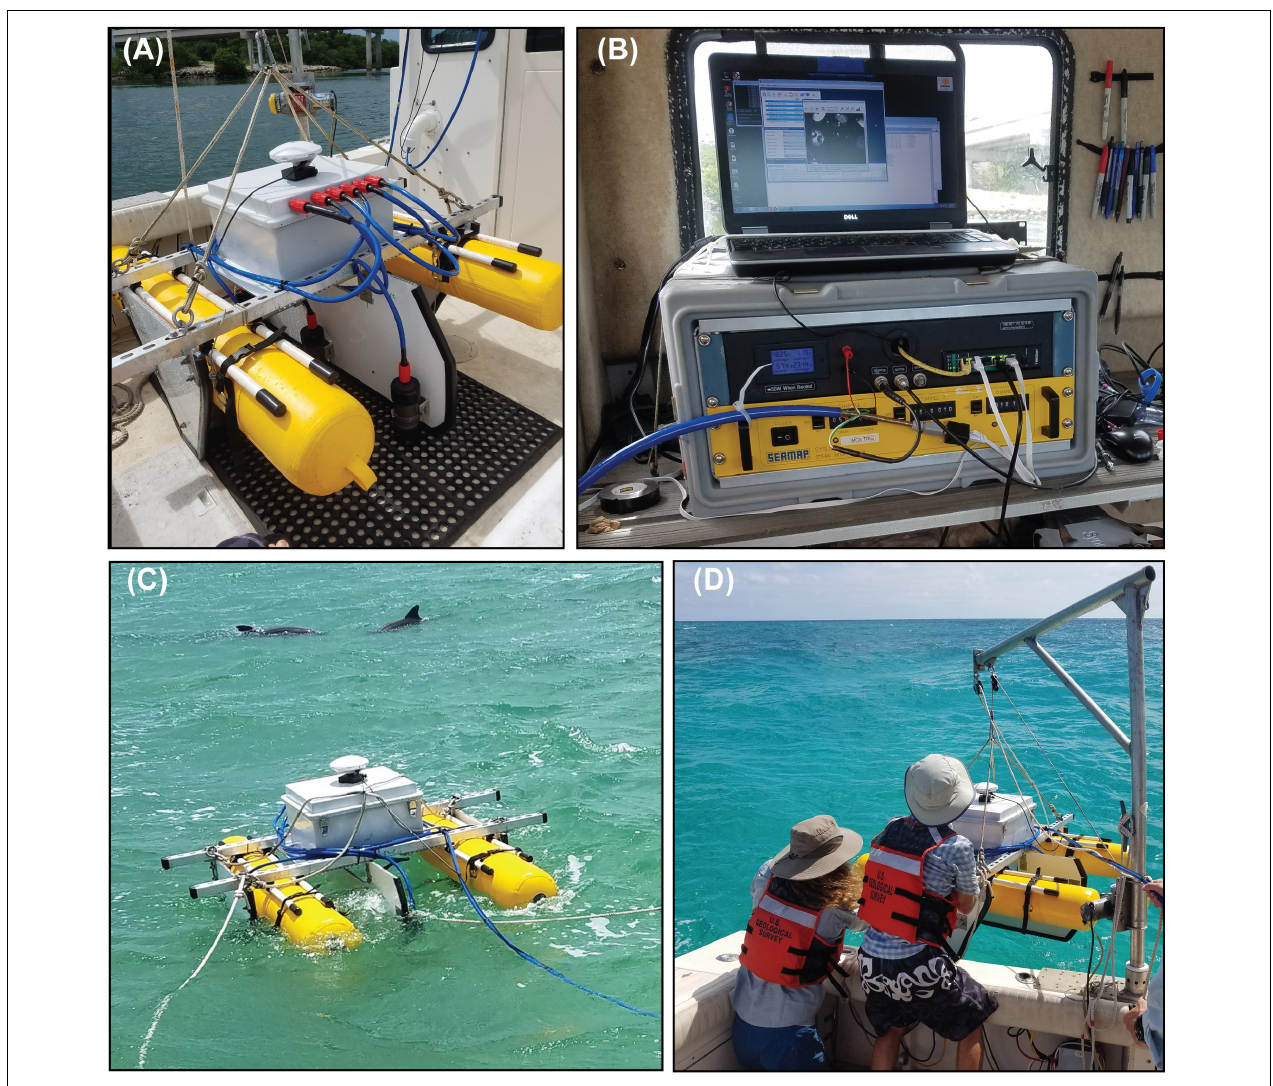
FIGURE 3 | Photographs of field operations with the SQUID-5 towed surface vehicle: (A) the vehicle on the deck of the support vessel rigged for deployment; (B) the control station onboard the support vessel consisting of laptop, power supply, NTP time server, Ethernet hub, power supply, and trigger signal generating electronics; (C) the towed surface vehicle in operation; and (D) launch and recovery of the